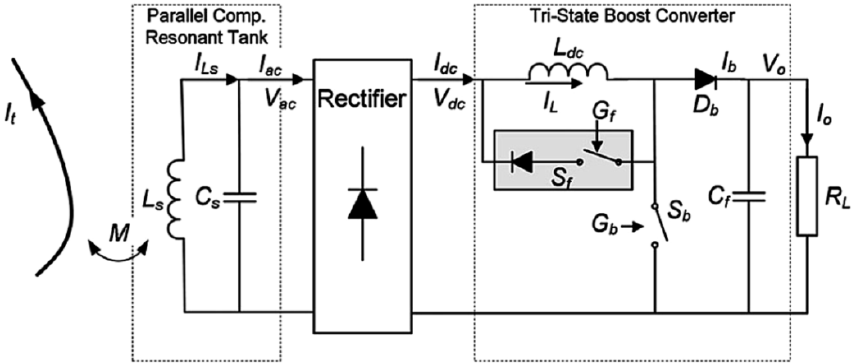
on, S off)”, “power delivery (S b f off, S b f